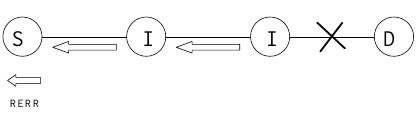
Fig. 3. Transferring RERR